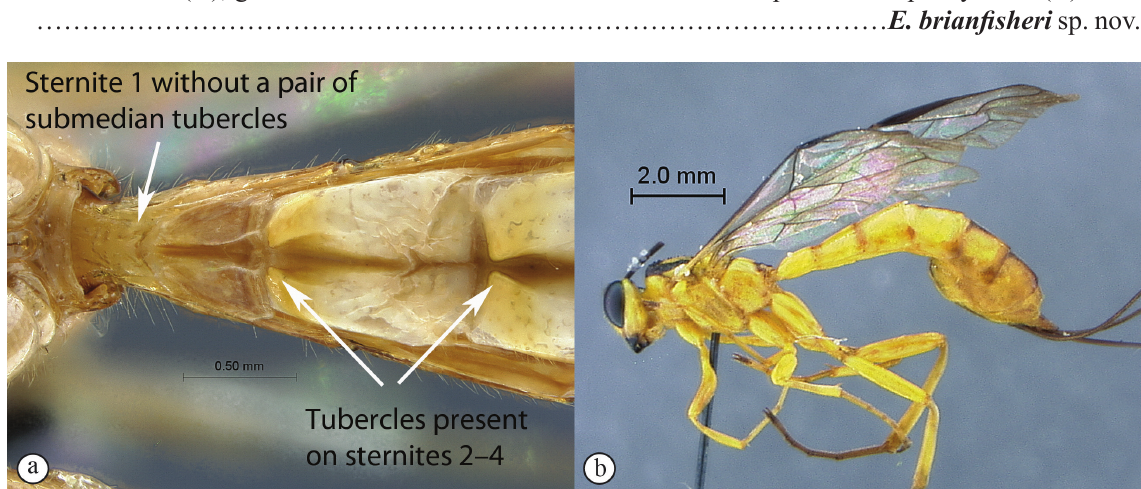
6. Anterior sclerotized part of sternite 1 with a pair of submedian tubercles, tubercles also present on sternites 2–4 (A); general coloration dark testaceous to black interspersed with pale yellow (B) ……